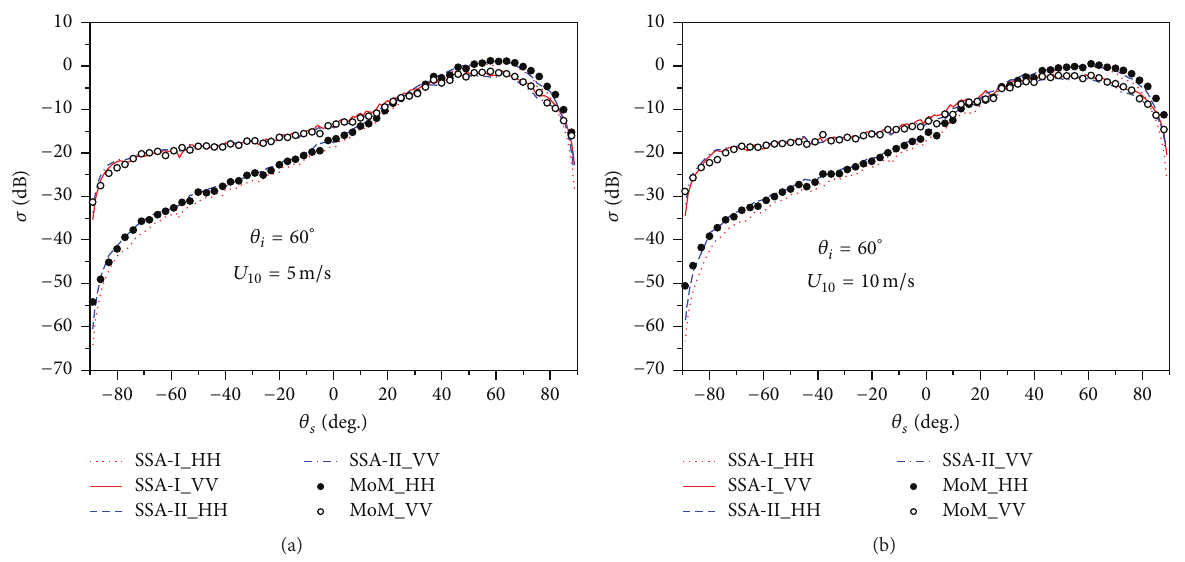
Figure 3: Validation of SSA by comparison with MoM for 1D case. (a) Wind speed 𝑈 10 = 5 m/s and (b) wind speed 𝑈 10 = 10 m/s.